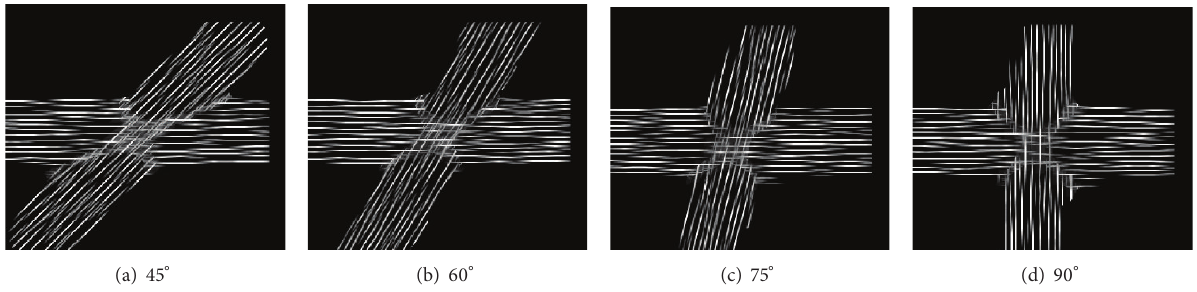
Figure 12: LIC results of two fibers crossing at different